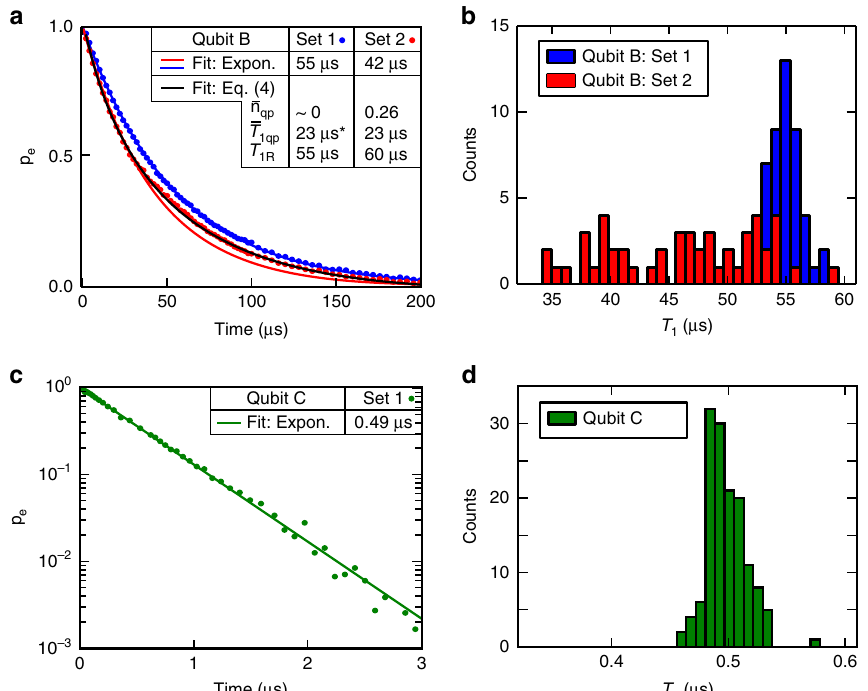
Figure 4 | T 1 temporal variation and quasiparticles. ( a ) Energy-relaxation measurements (set 1 and set 2) at o q ¼ D B for qubit B. Each set comprises the average of 50 individual decay traces acquired sequentially in 4-min intervals. Set 1 exhibits purely exponential decay with T 1 ¼ 55 m s, whereas set 2 (acquired 17h after set 1) exhibits a non-exponential decay function. The black line is a fit to equation (3) assuming the non-exponential decay is due to quasiparticle fluctuations (see text). Inset: tabulation of the values obtained from fitting functions. The ‘*’ indicates an assumed value from set 2 (not a fit value). ( b ) Histograms of T 1 values obtained by exponential fits of the individual traces forming the two data sets in a . For set 2, the fitting is restricted to the first 40 m s to capture primarily the fast initial decay. ( c ) Energy-relaxation measurements at o q ¼ D C for qubit C. The exponential decay function is manifest as a linear fit on the log plot with time constant T 1 ¼ 0.49 m s. ( d ) Histograms of T 1 values obtained from repeated measurements of qubit C. Both the exponential decay function ( c ) and the consistently tight T 1 distribution ( d ) indicate a relative insensitivity to quasiparticle number